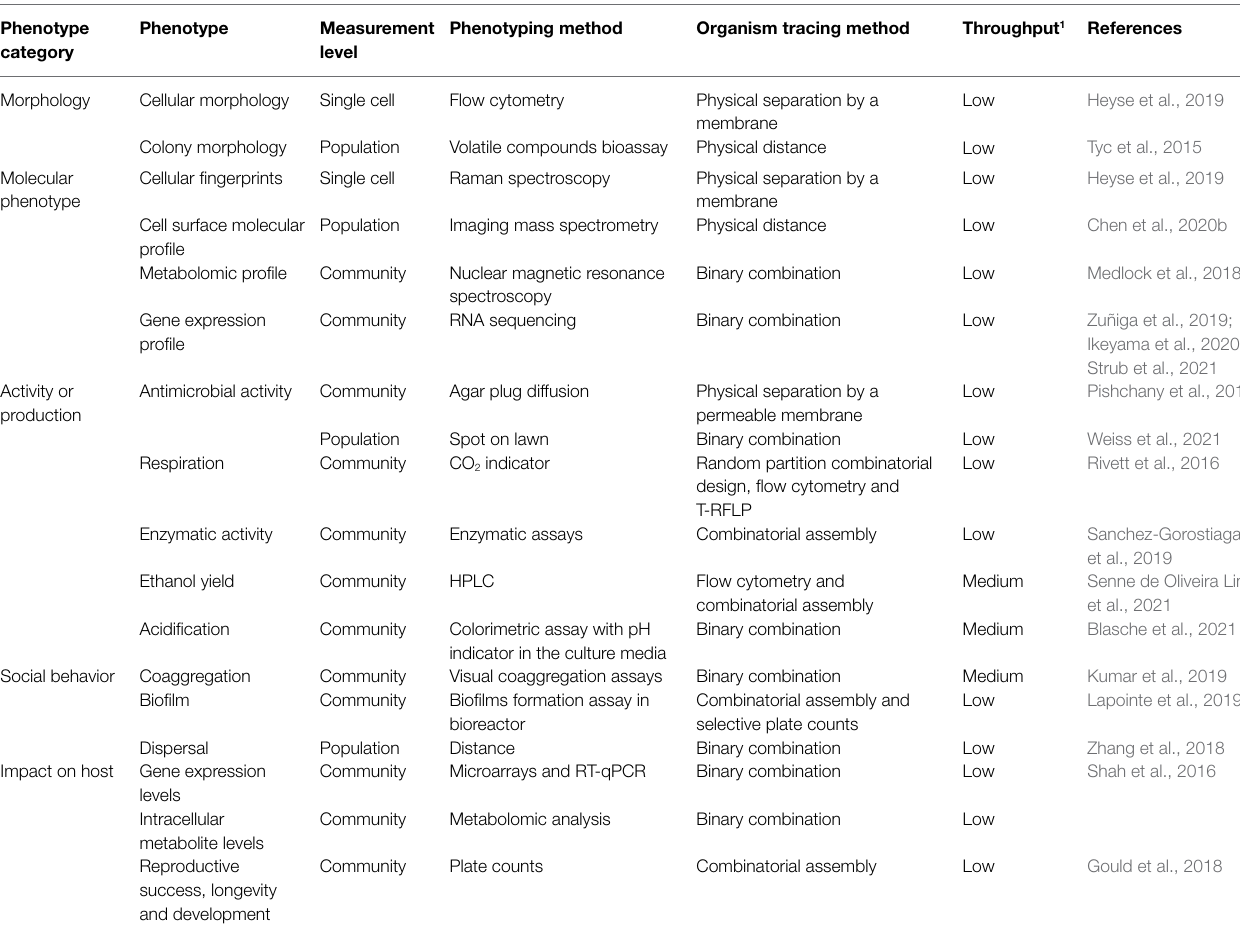
TABLE 2 | Approaches to measure functional microbial